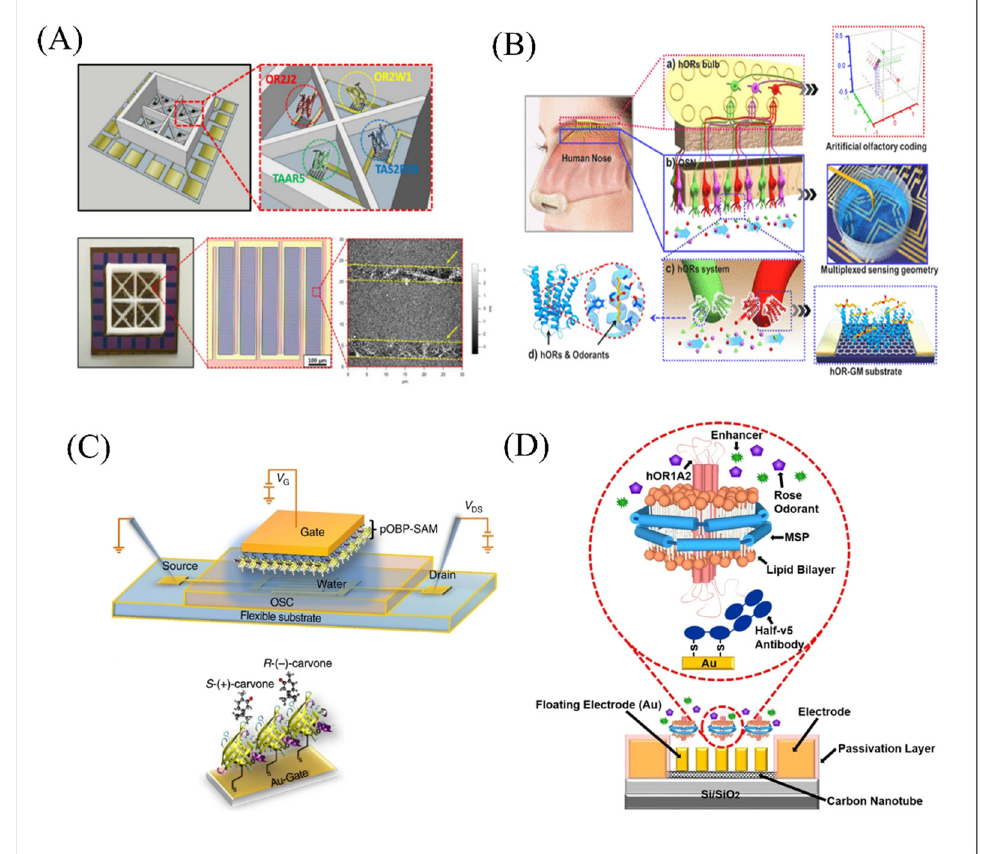
Figure 3. Schematic of biomimetic olfactory and gustatory biosensors based on FET functionalized with different types of sensitive materials. ( A ) Schematic diagram of multi-channel-type CNT-FET platform functionalized by human OR2J2, OR2W1, TAAR5, and TAS2R38. Reproduced with permission from Ref. [85]. ( B ) Schematic diagram of functional anatomy of human olfactory system and components of MSB-noses including graphene micropatterns and hORs for simulating each functional stage of the human nose. Reproduced with permission from Ref. [86]. ( C ) The schematic structure of WGOFET device functionalized with pOBP through a self-assembled monolayer (SAM). Reproduced with permission from Ref. [87]. ( D ) Schematic diagram of the floating electrode-based CNT-FET functionalized with nanodiscs embedded with hOR1A2 through half-v5 Ab fragments and thiol groups. Reproduced with permission from Ref. [89].